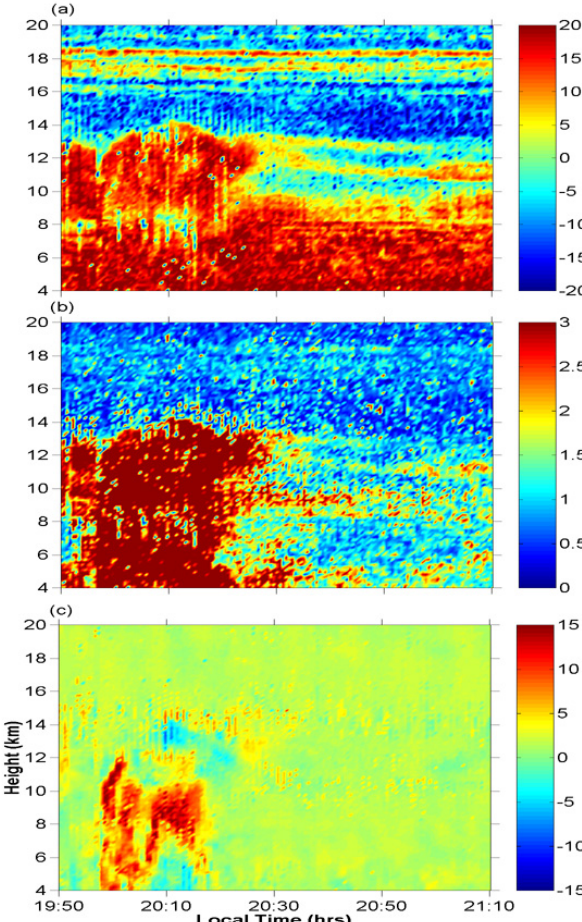
Fig. 9. Height-time sections of (a) VHF radar signal-to-noise ratio (dB), (b) spectral width(m/s) and (c) vertical velocity (m/s) for a multi cell convective system, as observed on 10 June